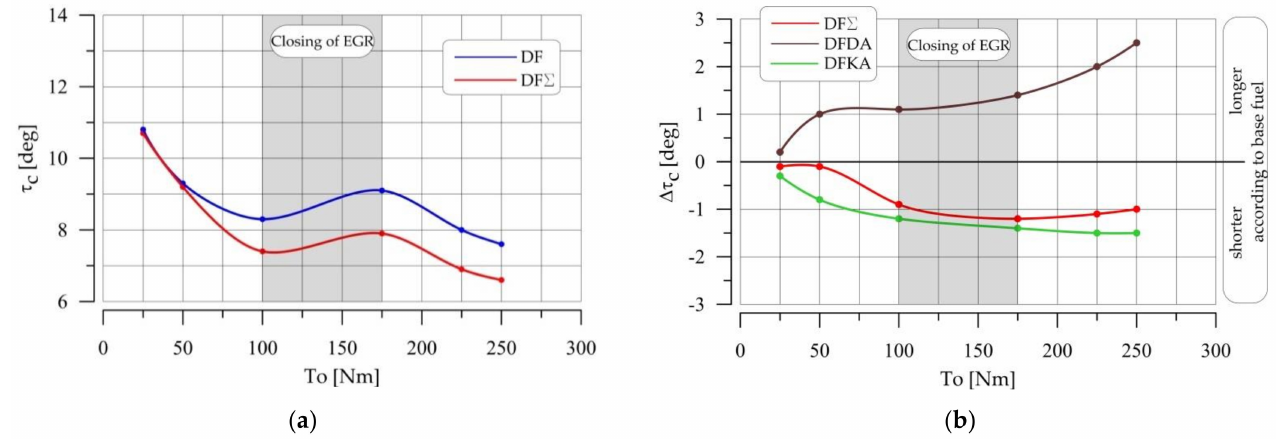
Figure 17. ( a ) Fuel self-ignition delay vs. engine torque; ( b ) Difference in fuel self-ignition delay vs. engine torque in relation to the base